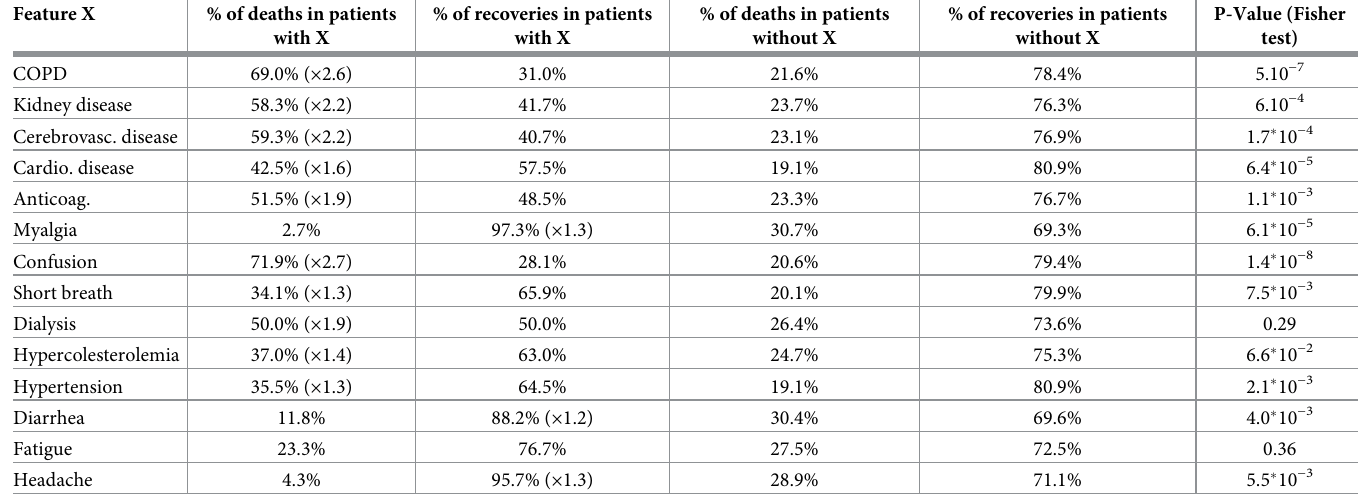
Table 2. Results of the bivariate statistical analysis for categorical variables. Contingency table and results of the Fisher test between the categorical variables present in Fig 3 and the outcome. The most impactful deaths (recoveries) fold increases with respect to the dataset average are reported within the brackets in the second and third columns,